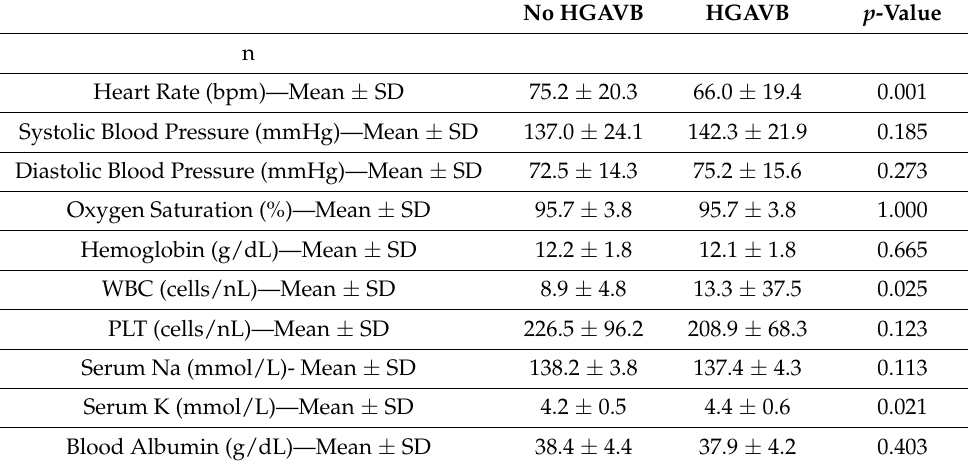
Table 2. Clinical characteristics of patients with and without high grade AV block (HGAVB).